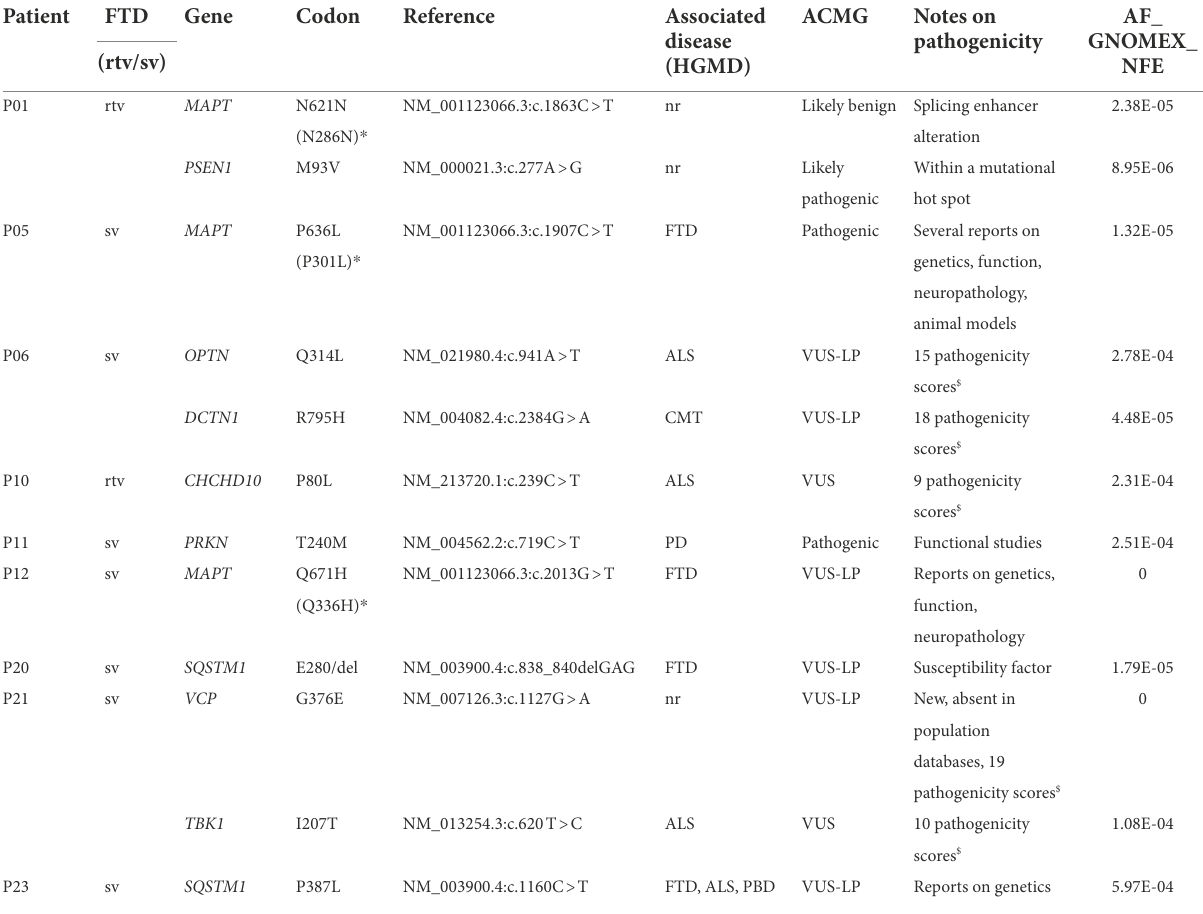
TABLE 2 Variants present in